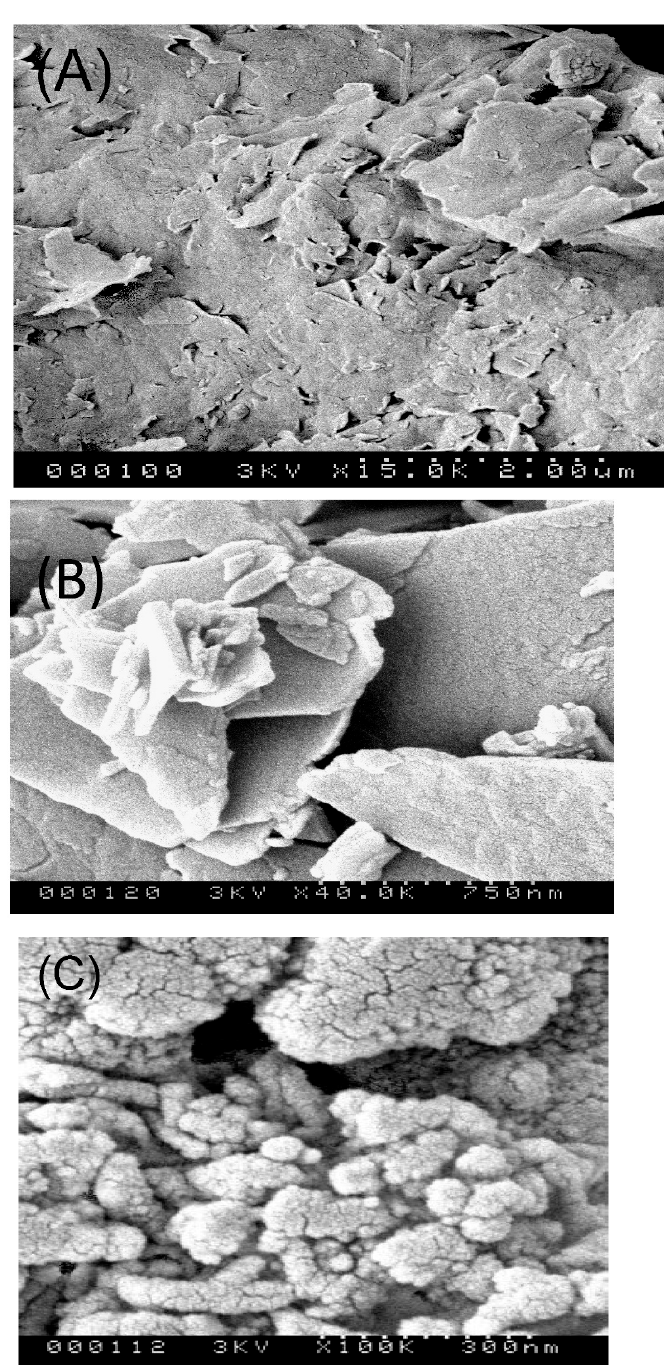
Figure 5. ( A ) SEM micrograph for Cloisite 20A clay powder. ( B ) SEM micrograph of PACN synthe- Figure 5. ( A ). SEM micrograph for Cloisite 20A clay powder. ( B ). SEM micrograph of PACN syn- thesized by using 0.7 wt.% of oxidant, APS. ( C ). SEM micrograph of PACN synthesized by using sized by using 0.7 wt.% of oxidant, APS. ( C ) SEM micrograph of PACN synthesized by using 3.5 wt.% 3.5 wt.% of oxidant, APS. of oxidant,